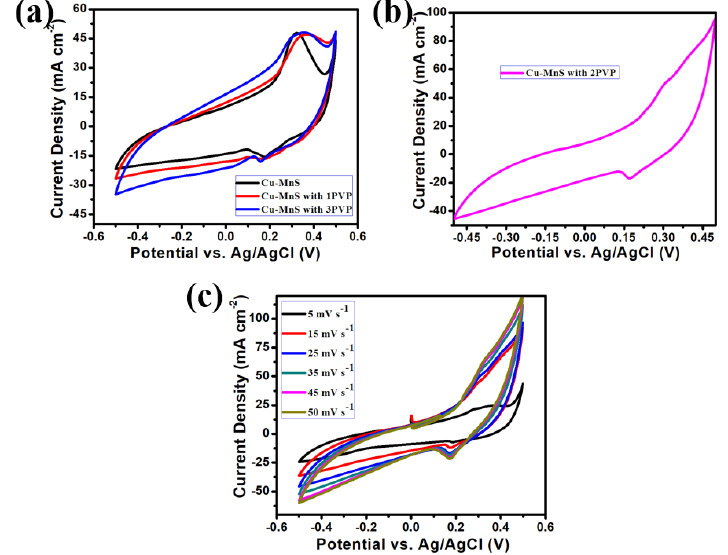
Figure 7. Cyclic voltammetry of ( a ) Cu-MnS, Cu-MnS with 1PVP, Cu-MnS with 3PVP and ( b ) Cu-MnS with 2PVP curves at scan rate of 25 mV s −1 . ( c ) CV of Cu-MnS with 2PVP electrodes at various scan rate from 5 to 50 mV s −1 .